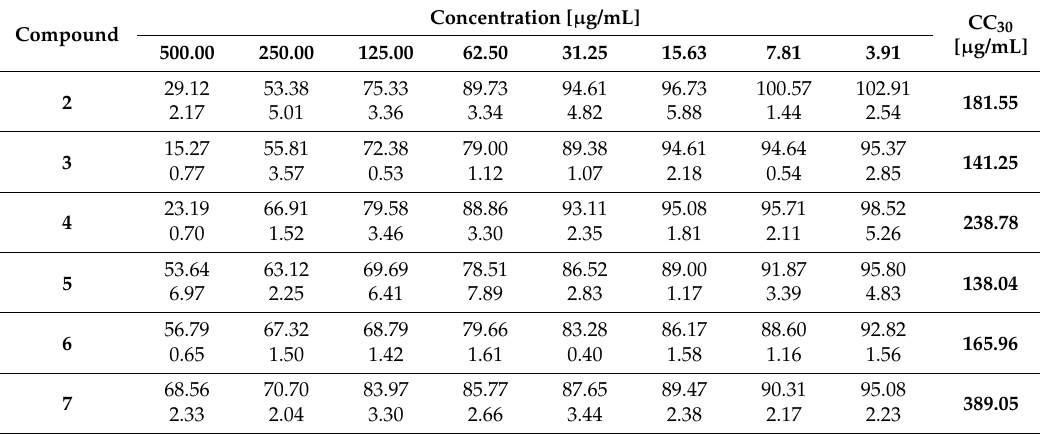
Table 2. The viability of L929 cells [in % of viable L929 cells ± SD] in the concentration range of 2 – 22 between 3.91 to 500 µg/mL.